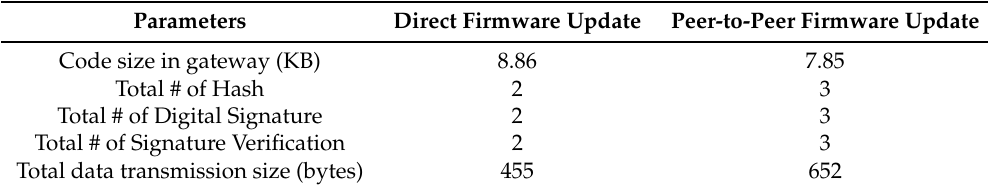
Table 6. Comparison of computational complexity and data transmission size between direct firmware update and peer-to-peer firmware